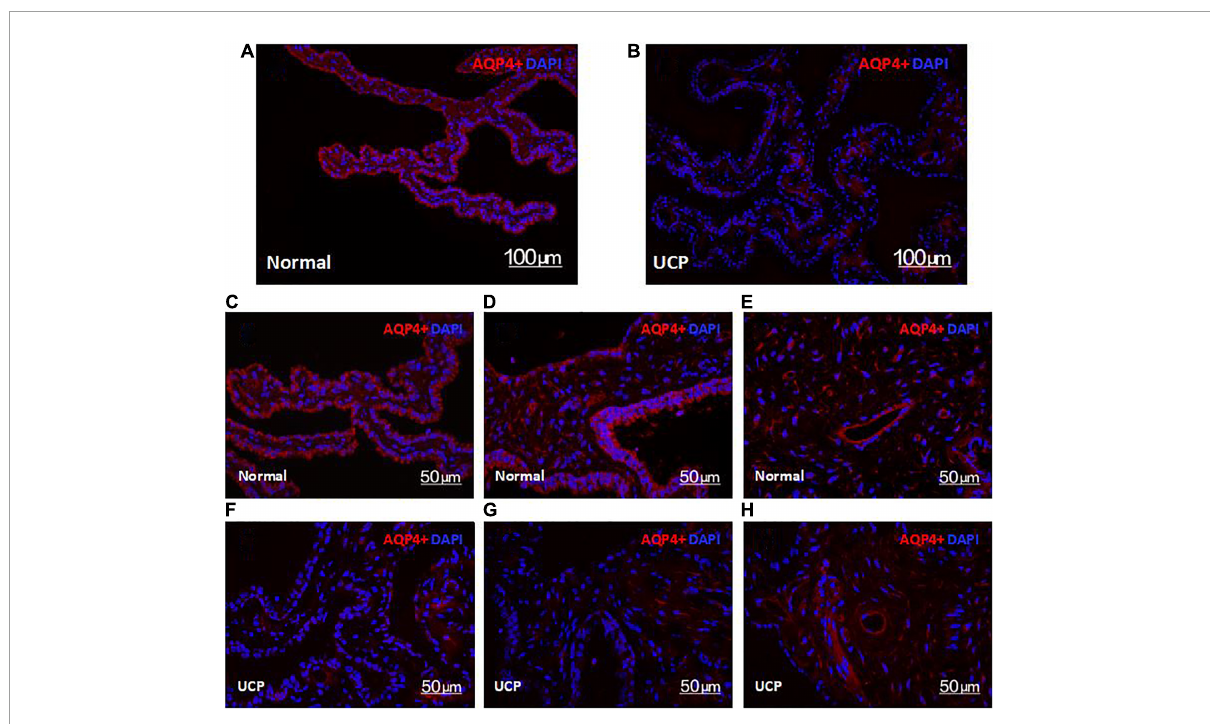
FIGURE4 Confocal microscopy images of the expression of AQP4 in the normal ciliary body (A) and UCP postoperative (B) . Scale bars 100 µ m. (C–G) are ciliary, processes, (E,H) are ciliary, muscles. Scale bars 50 µ